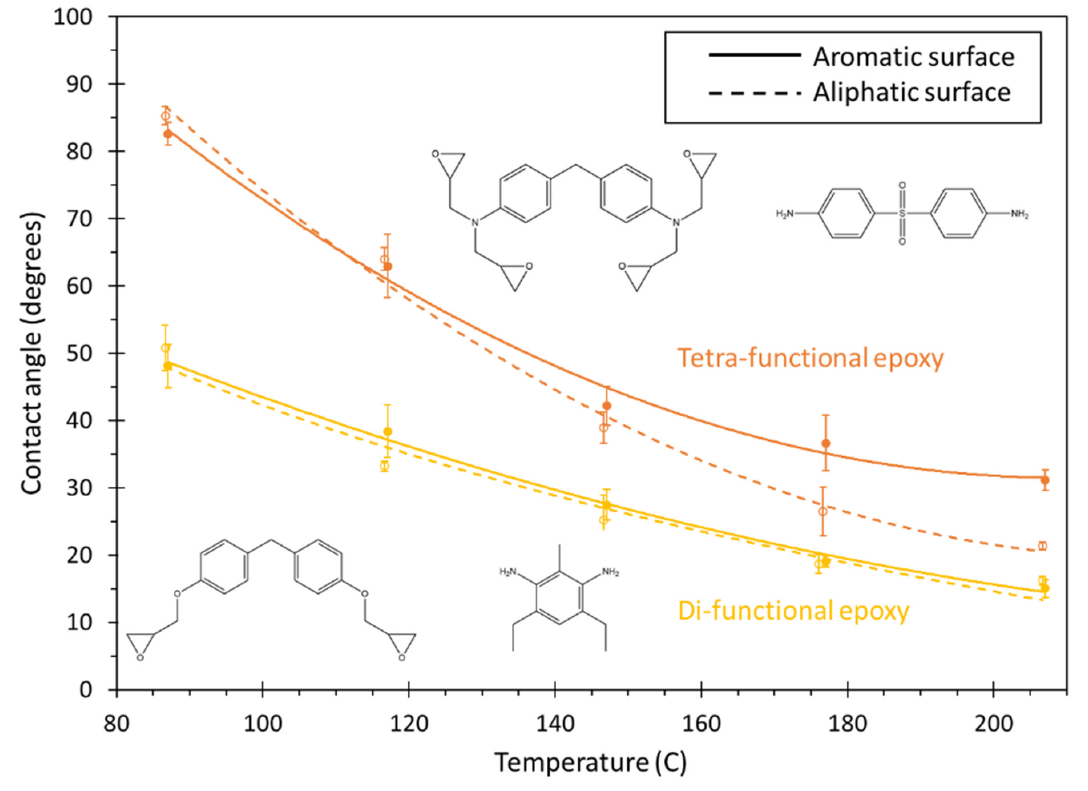
Figure 17. Plot of contact angle vs. temperature for both epoxy systems. The lines are curve fits to the data, and the error bars represent the standard error of replicate predictions.